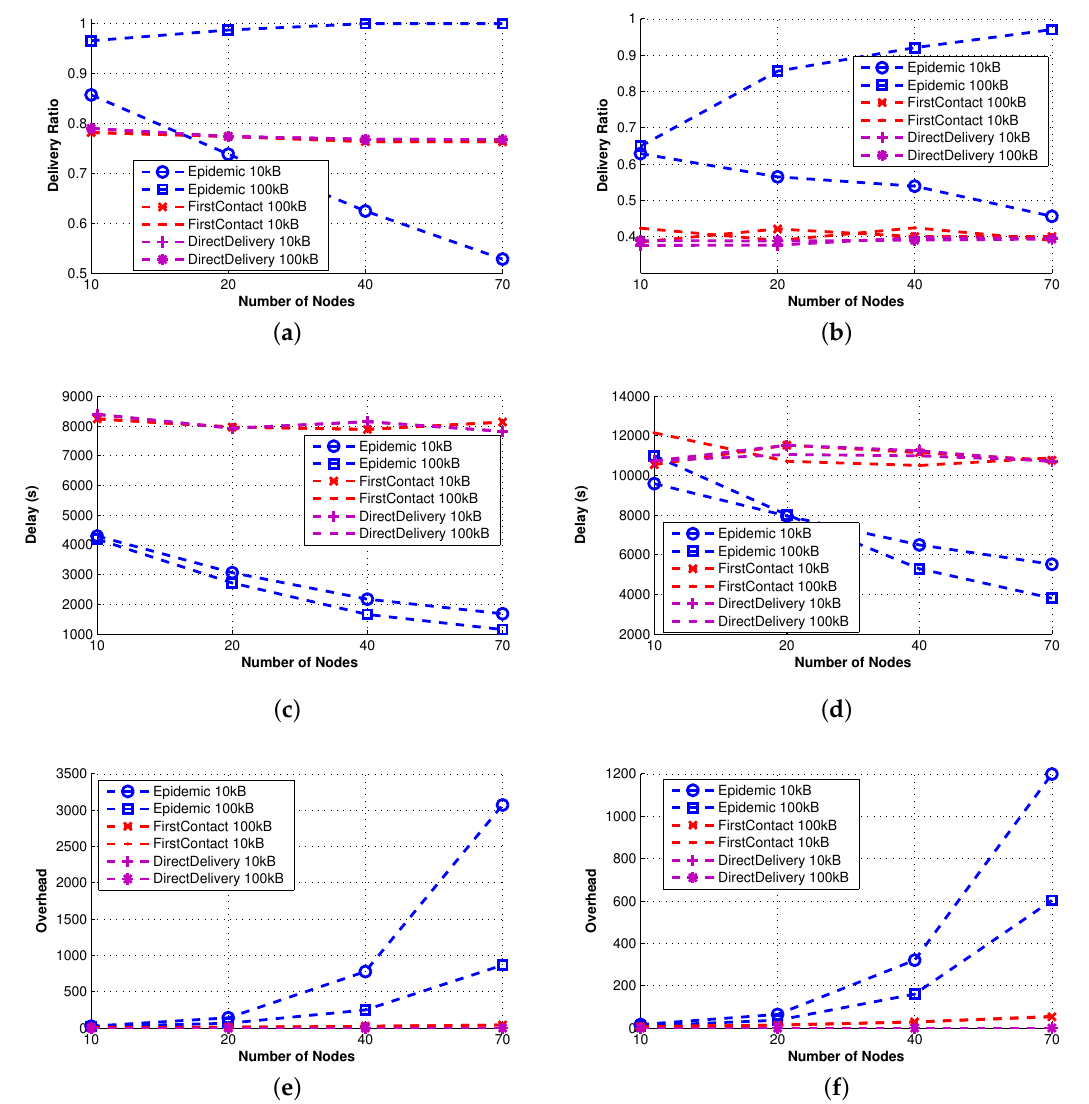
Figure 2. Synthetic traces. Random walk ( a , c , e ); Levy Walk ( b , d , f ). Simple